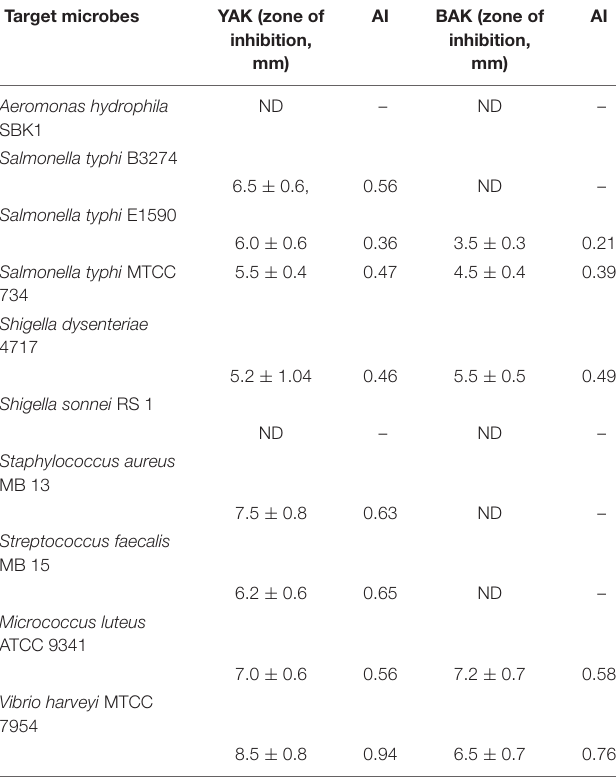
TABLE 3 | | Antimicrobial activity of aqueous extract of two types of khambir